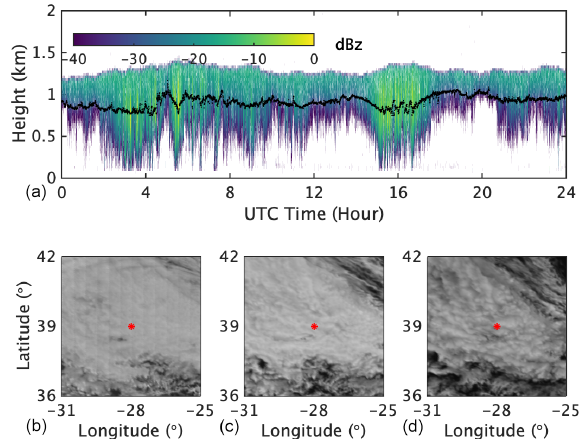
Figure 3. Example of closed cells from 4 March 2016. (a) Time– height profile of the best estimate radar reflectivity from the ARSCL value-added product. (b) Reflectance at 0.65µm wavelength from Meteosat observations.